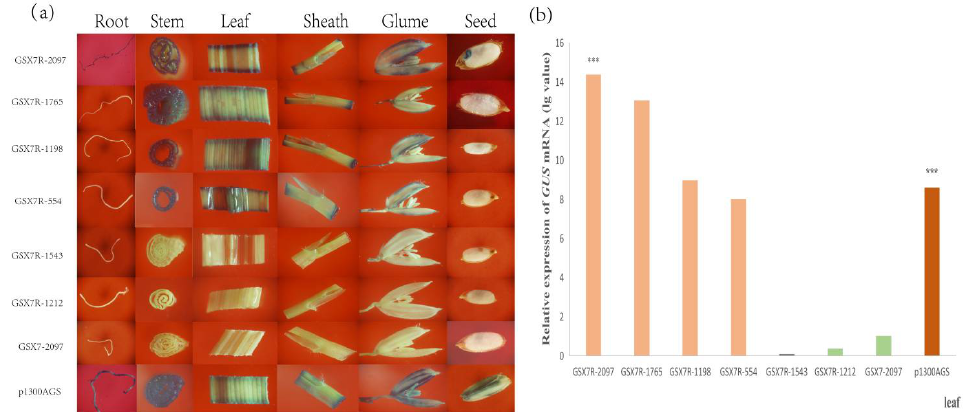
Figure 7. GUS staining and quantification of GUS mRNA transcript of transgenic rice containing